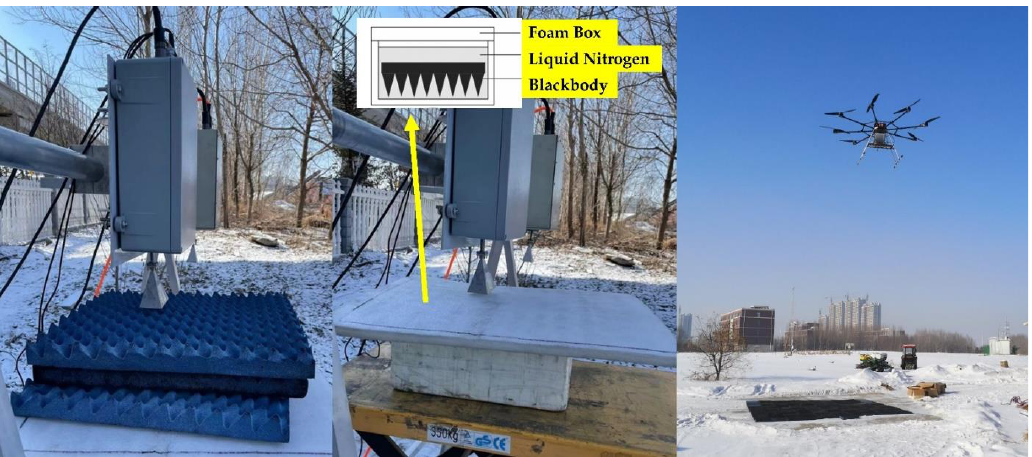
Figure 6. Calibration of microwave radiometer: blackbody (left), liquid nitrogen (middle), and fly- ing test (right). test